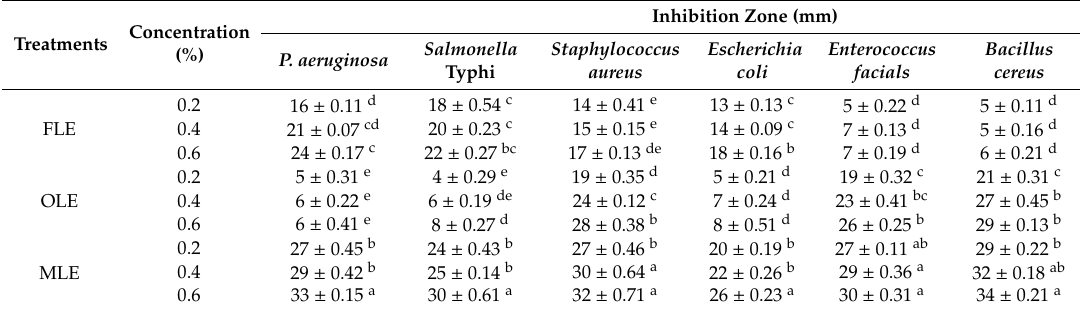
Table 6. The antimicrobial activity of OLE, FLE, and their mixture against P. aeruginosa , S . Typhi, Staph. aureus, E. coli, E. faecalis, and B. cereus